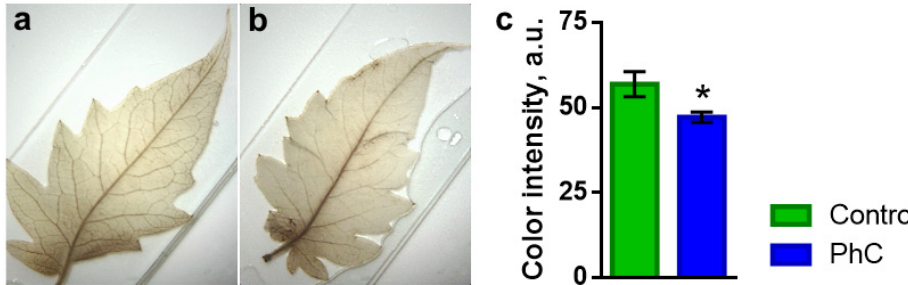
Figure 7. Influence of photoconversion coatings on the content of H 2 O 2 in the leaves of tomato plants: ( a , b ) photograph of leaves of a control tomato plant and a plant grown under a photoconversion coating, stained with DAB; ( c ) relative content of H 2 O 2 in the leaves of control plants and plants grown under a photoconversion coating. *: p < 0.05.